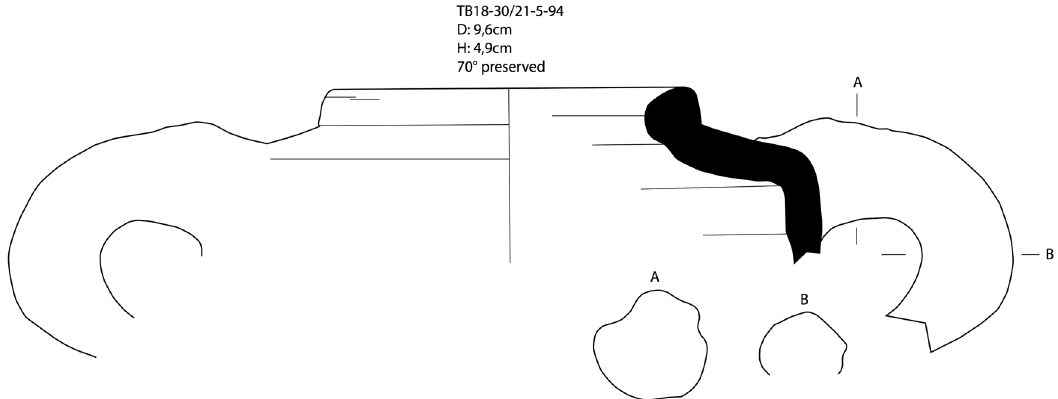
Figure 4: Digital drawing based on scanned pencil drawing ( cf. Figure 3 for pencil drawing ) .